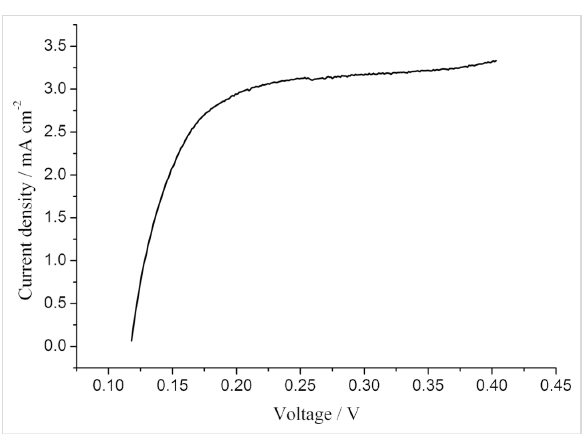
Figure 9: Oxidation current of hydrogen diffusing through the mem- brane for PBI-O-PhT with 0.75 wt % Zr(OAc) 4 . H 2 /N 2 operation, T = 160